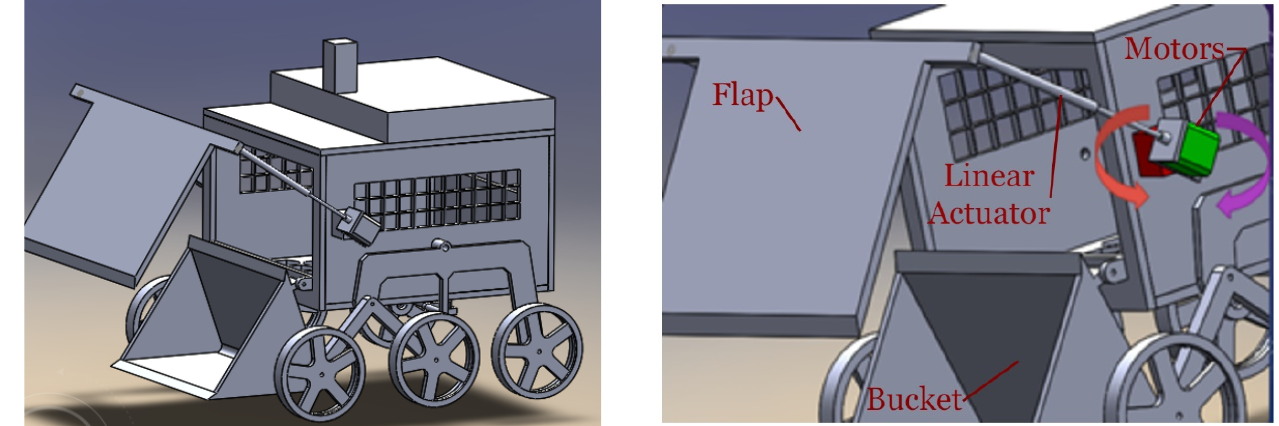
Figure 1. Robot’s body ( left ) and flap motors ( right ).